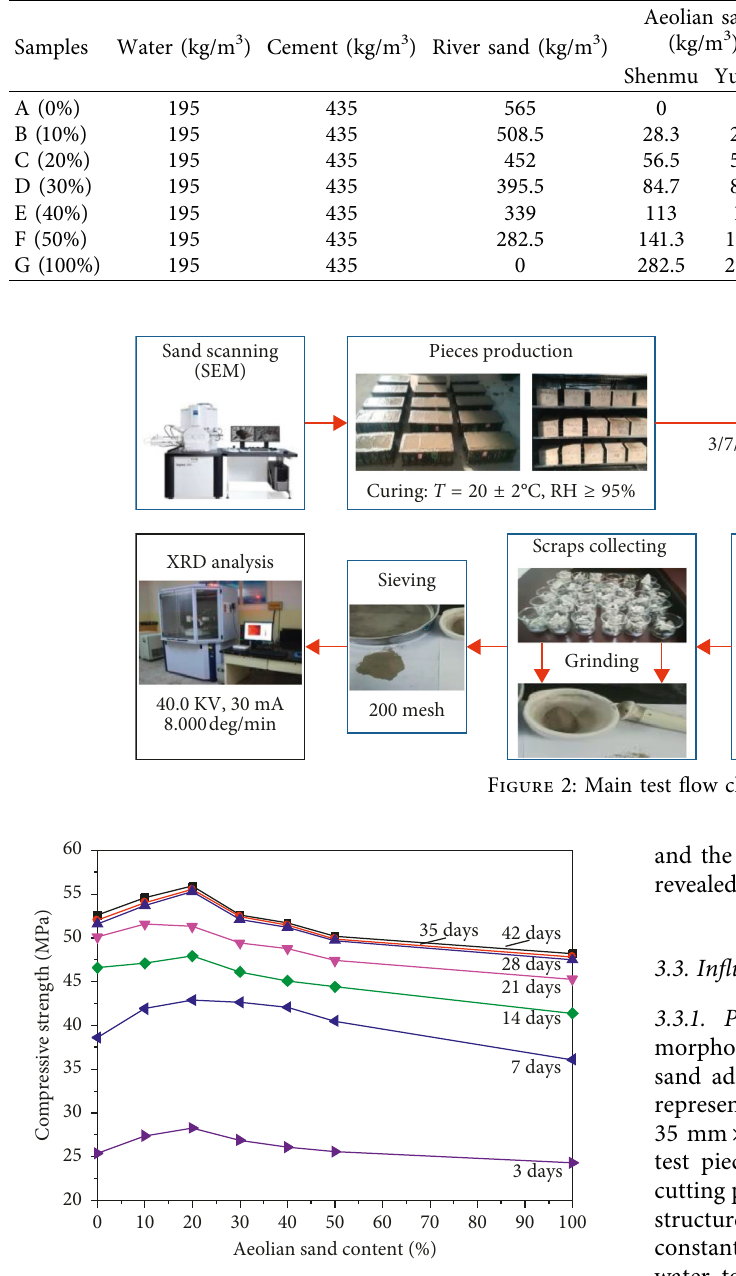
Figure 3: Relation between compressive strength and aeolian sand